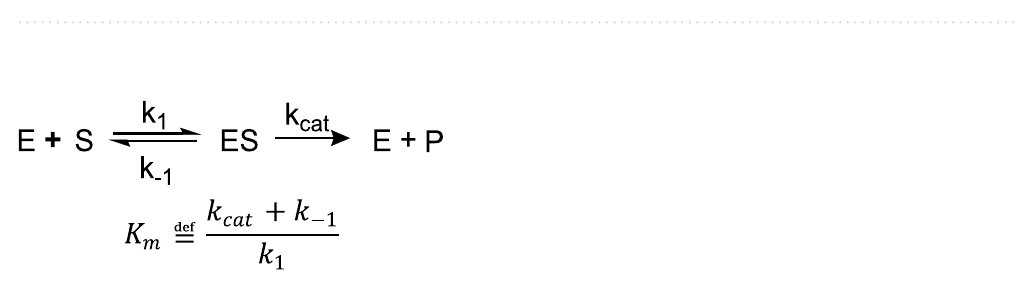
Scheme 1. Simplified enzymatic reaction for Michaelis Menten kinetics model and definition of K m